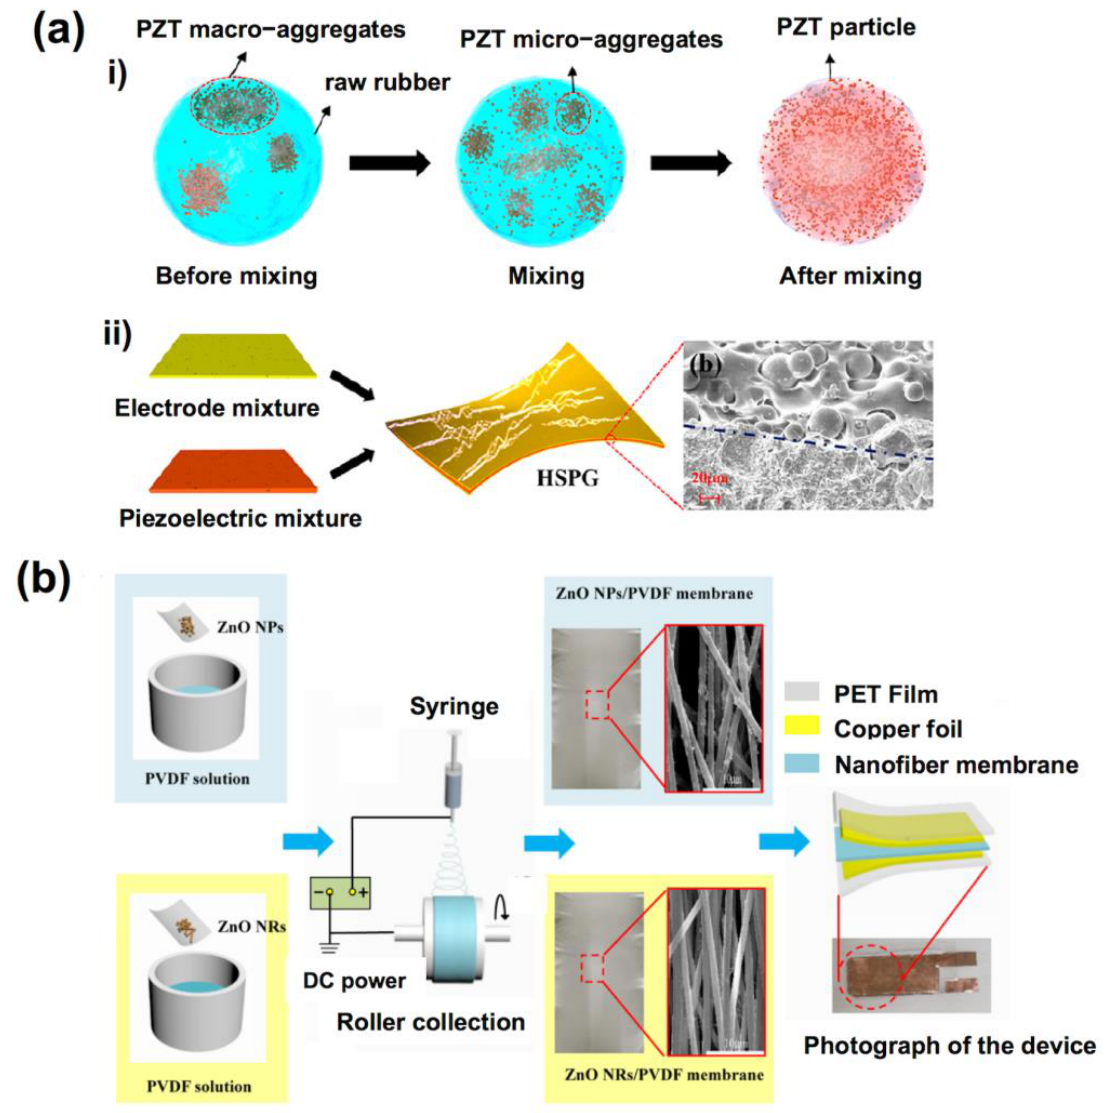
Figure 4. ( a ) Fabrication process and characterizations of the high performance PZT-based stretchable piezoelectric composite [61]; ( b ) schematic illustration of ZnO/PVDF nanocomposite fibrous membrane [62].